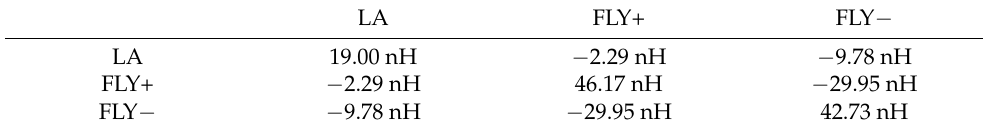
Table 3. The stray self-inductance and mutual inductance matrix of the inner bus bar commutation paths.